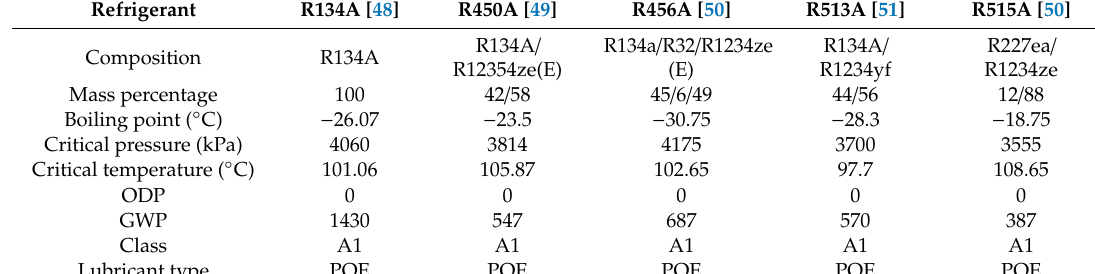
Figure 5. Refrigerant classification.